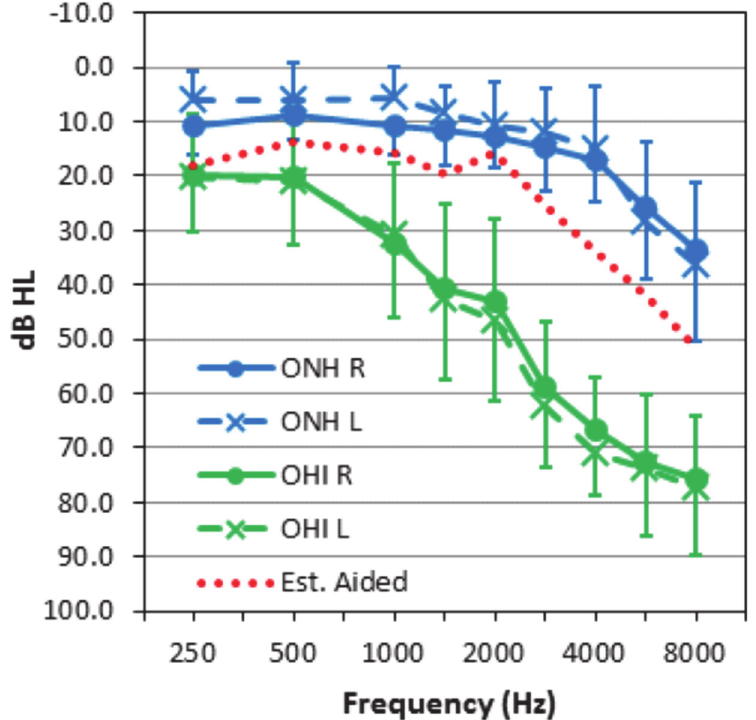
Fig 1. Average audiograms for 24 OHI listeners (green) and 16 ONH listeners (blue). Error bars show standard deviation. The dotted red line shows the estimated average aided audiogram based on prescriptive target for the average OHI